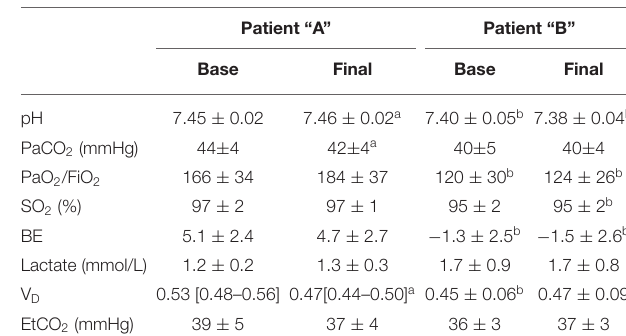
TABLE 2 | The average of blood gas results and physiological dead space ratios at the initial (base) and at the terminating (final) positive end-expiratory pressure (PEEP) levels of the daily trials.